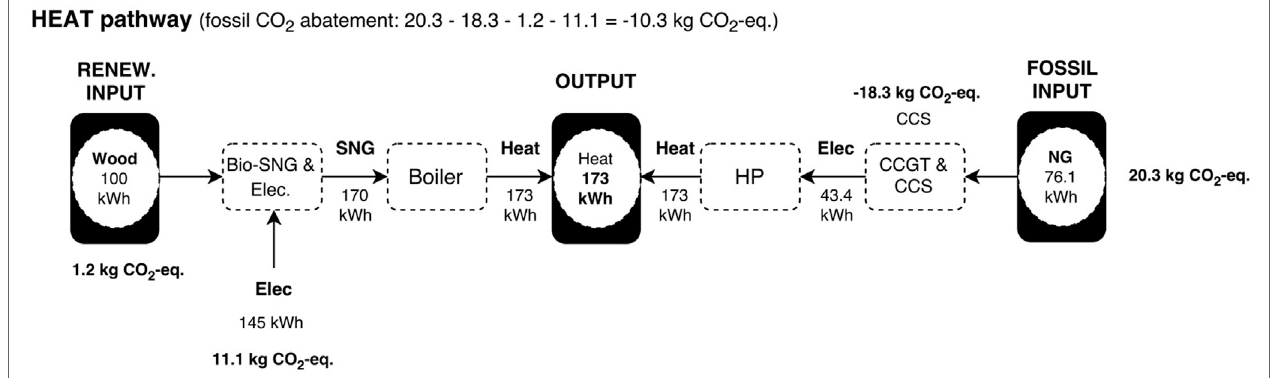
FigUre 4 | Substitution pathway with the minimum CO 2 abatement potential ( −